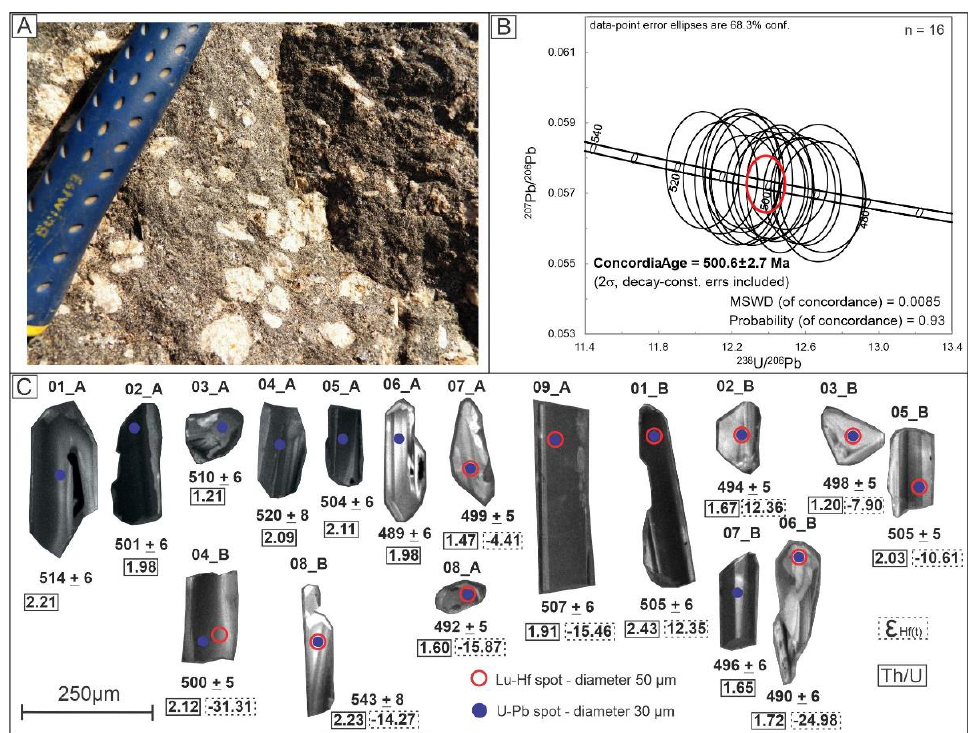
Figure 6. ( A ) A representative sample of the SAIC hybrid rock from the point SAIC-07. ( B ) Concord age for the sample SAIC-07A. ( C ) Cathodoluminescence image of the analyzed zircon grains.